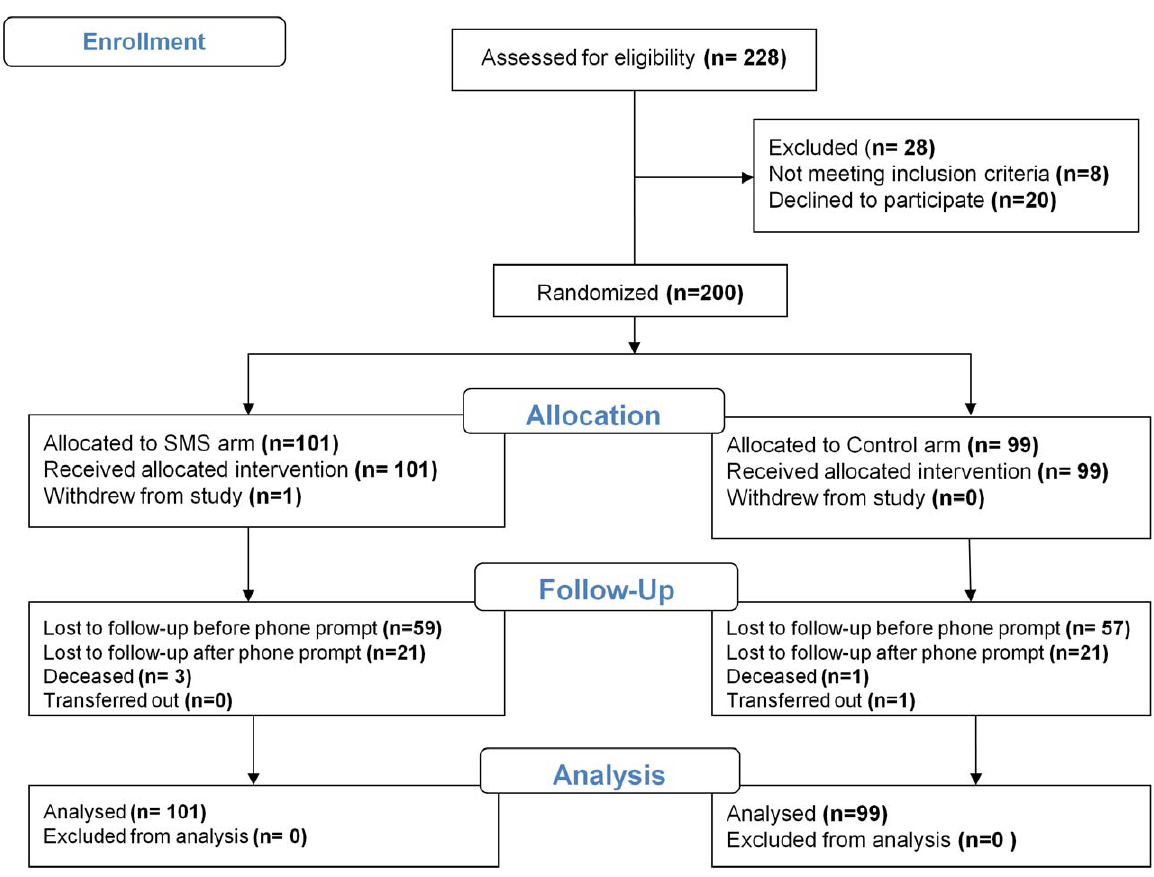
Figure 1. CONSORT flow diagram for CAMPS trial.